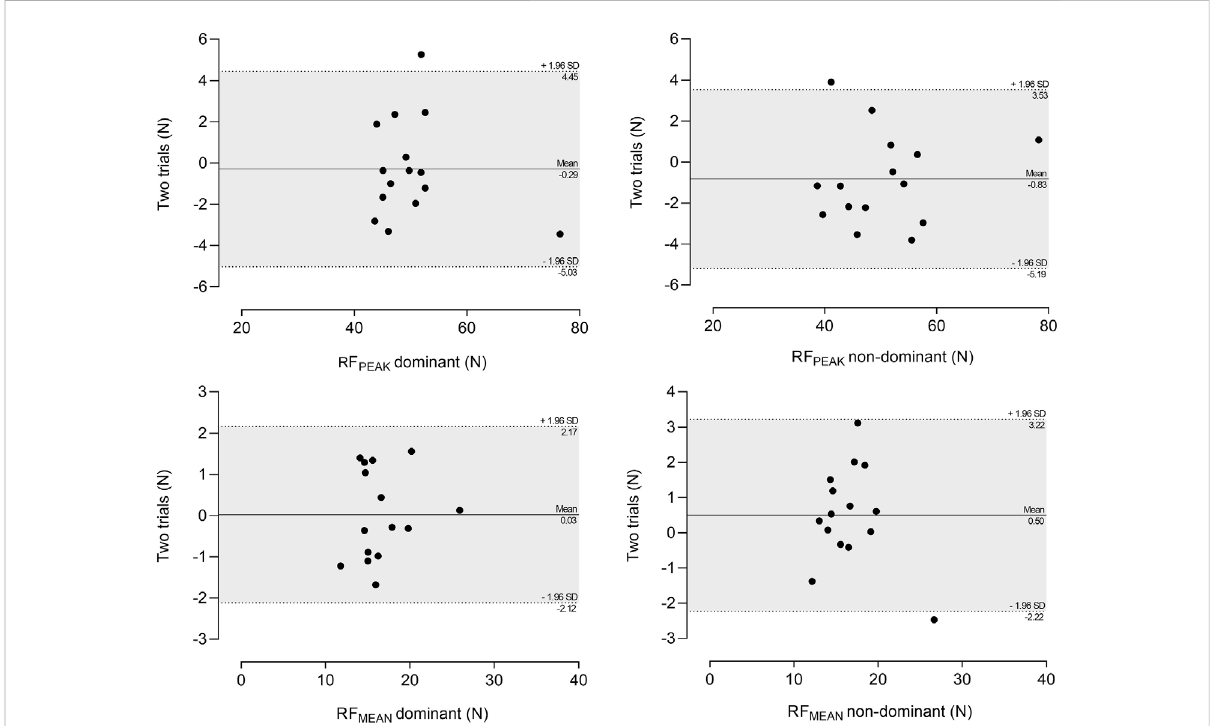
FIGURE 1 Bland-Altmanplots ofthedifferencebetweenT1and T2(y-axis) and meanofmeasurements (x-axis) for allvariables. Dotted linesrepresent the upperandlower95%LoA(meandifferences±1.96SDofthedifferences)andsolidlinesrepresentthemeandifferencesbetweenthetwotrials(bias). N, newton; RF PEAK , peak resultant force; RF MEAN , mean resultant